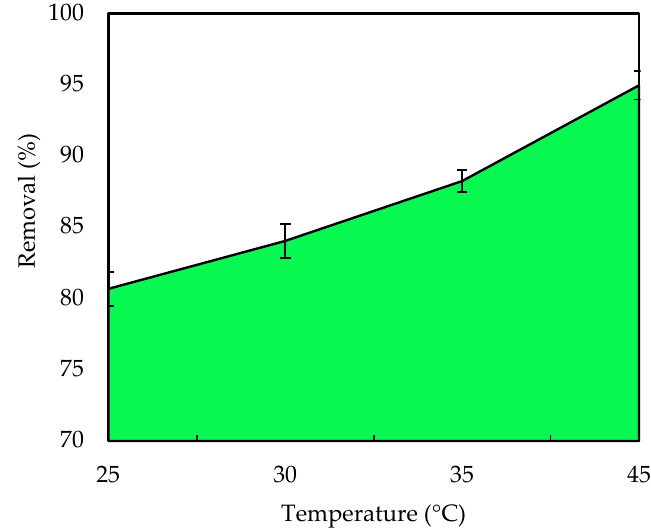
Figure 8. Effect of temperature on the removal of IV2R.